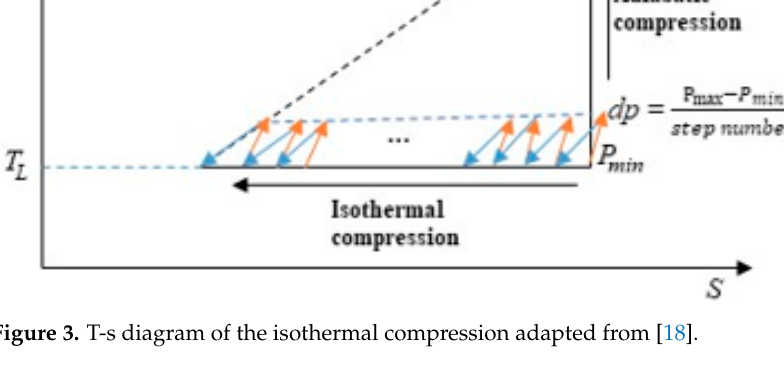
Figure 3. T-s diagram of the isothermal compression adapted from [18].